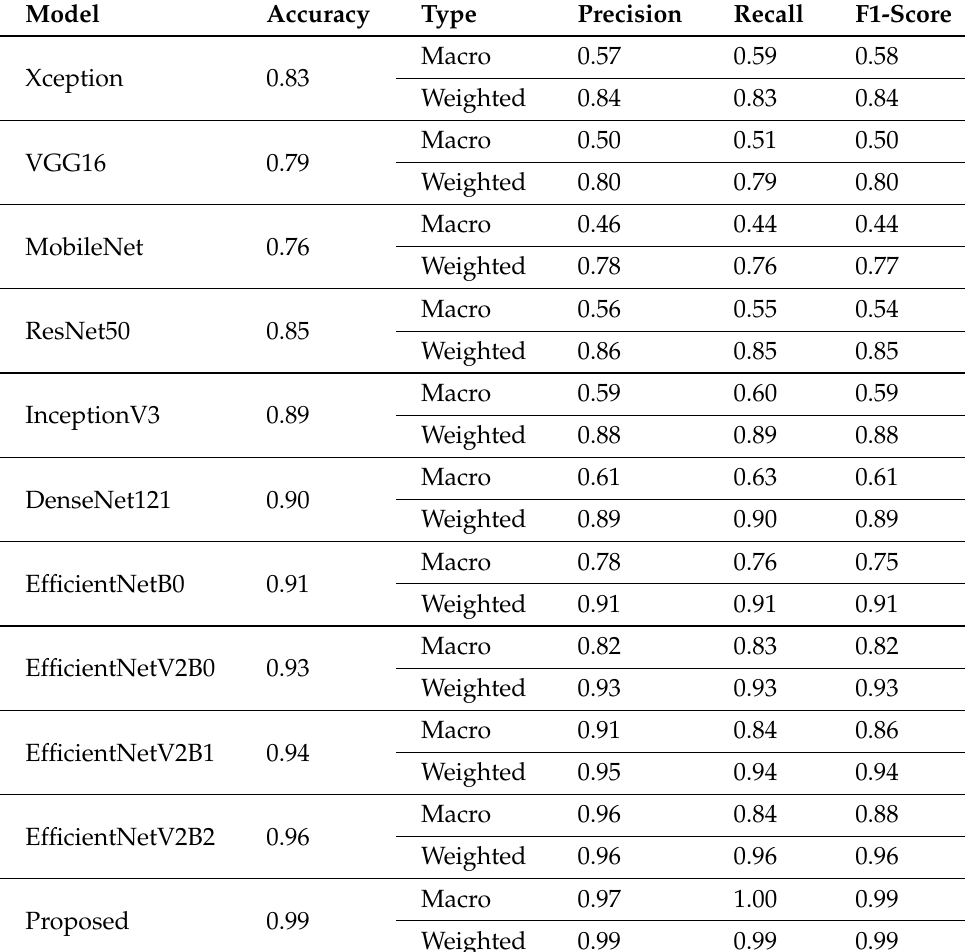
Table 5. Detailed results for skin disease